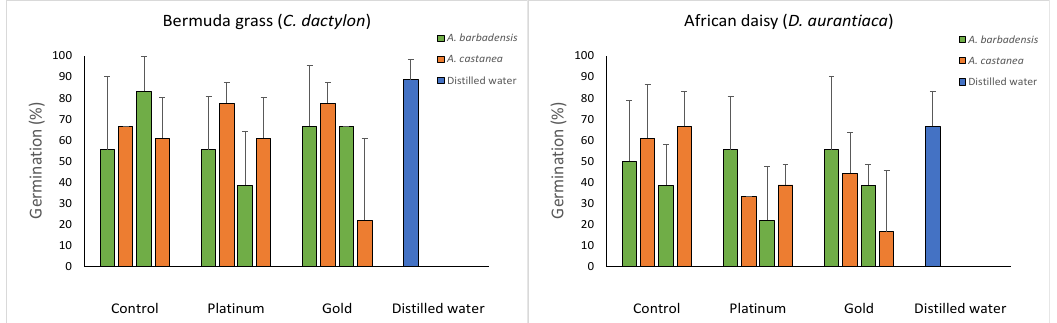
Figure 5. Germination rates (mean ± sd) of seeds from the target species treated with different concentrations of roots extracts of aloes from different soil treatments.